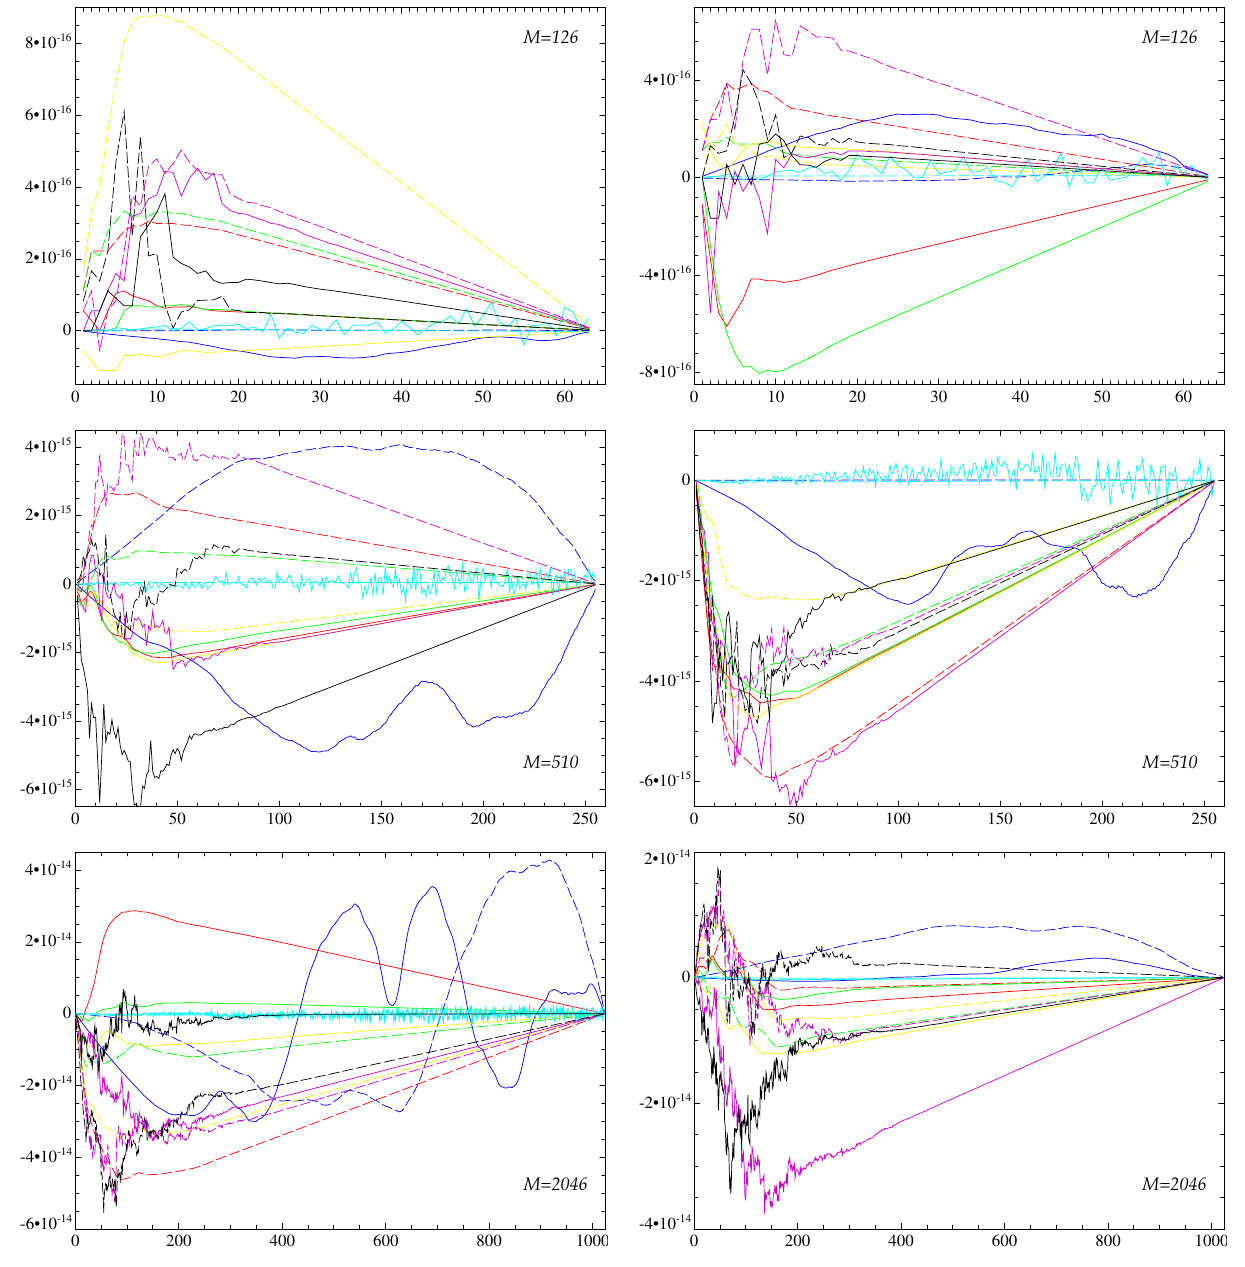
Figure 2. Errors (vertical axes) of approximate solutions obtained for sample test problems by algo- rithms 1 (red), 1 (cid:48) (green), 2 (blue), 2 (cid:48) (yellow), 3 (cyan), 3 (cid:48) (magenta) and 4 (black colour, respectively) for determining the coefficients of a linear combination of T (cid:63) n ( x 3 ) vs. the coefficient index number (horizontal axes). The panels show the plots for six randomly chosen sample runs for the three values of the resolution parameter M . Continuous line: odd-index coefficients; dashed line: even-index coefficients. In order to fit the panels, the error values have been divided by 10 3 for algorithm 2 and by 10 2 for algorithm